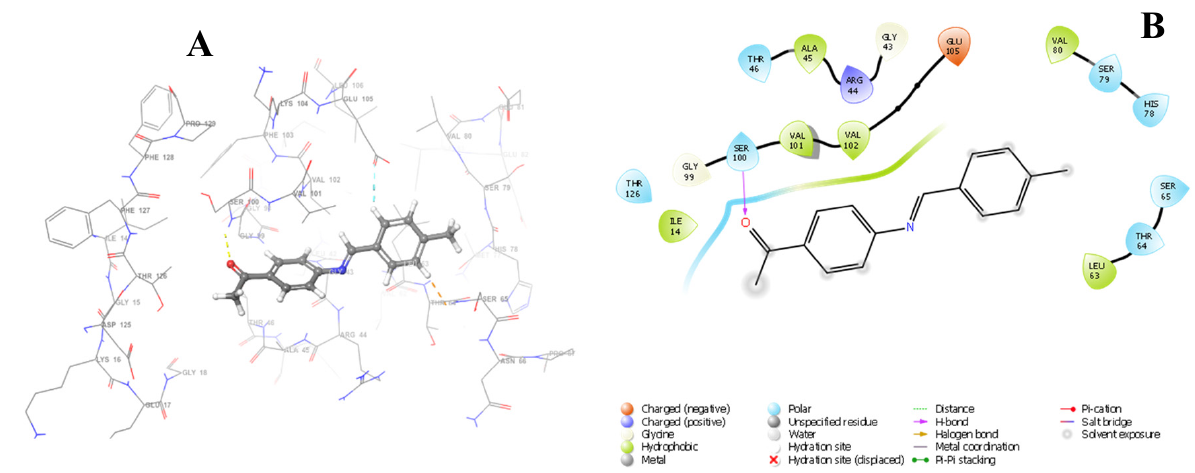
Figure 13. Three-dimensional binding model of 1 with 4M7U ( A ); two-dimensional diagram of 1 and interacting residues ( B ). Table 6. Energies of Schiff bases ( 1–4 ) and α -unsaturated amino carboxylic acids ( 5–8 ) with enzyme